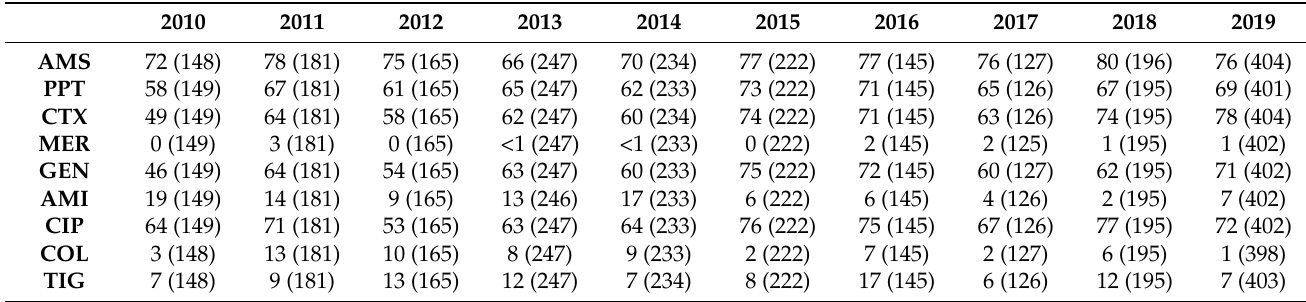
Table 9. Resistance of Klebsiella pneumoniae to antibiotics at the Department of Anesthesiology and Intensive Care Medicine in 2010–2019.